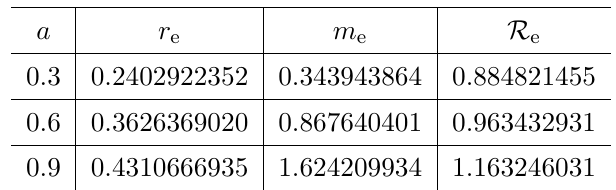
Table 2 . The numerical values of the horizon radius r e , mass parameter m e , and isoperimetric ratio R e with different rotation parameter a in the extremal uncharged black hole case ( q = 0 , l = 1 ). As before, one can plot the mass parameter m and the isoperimetric ratio R as functions of horizon radius r h